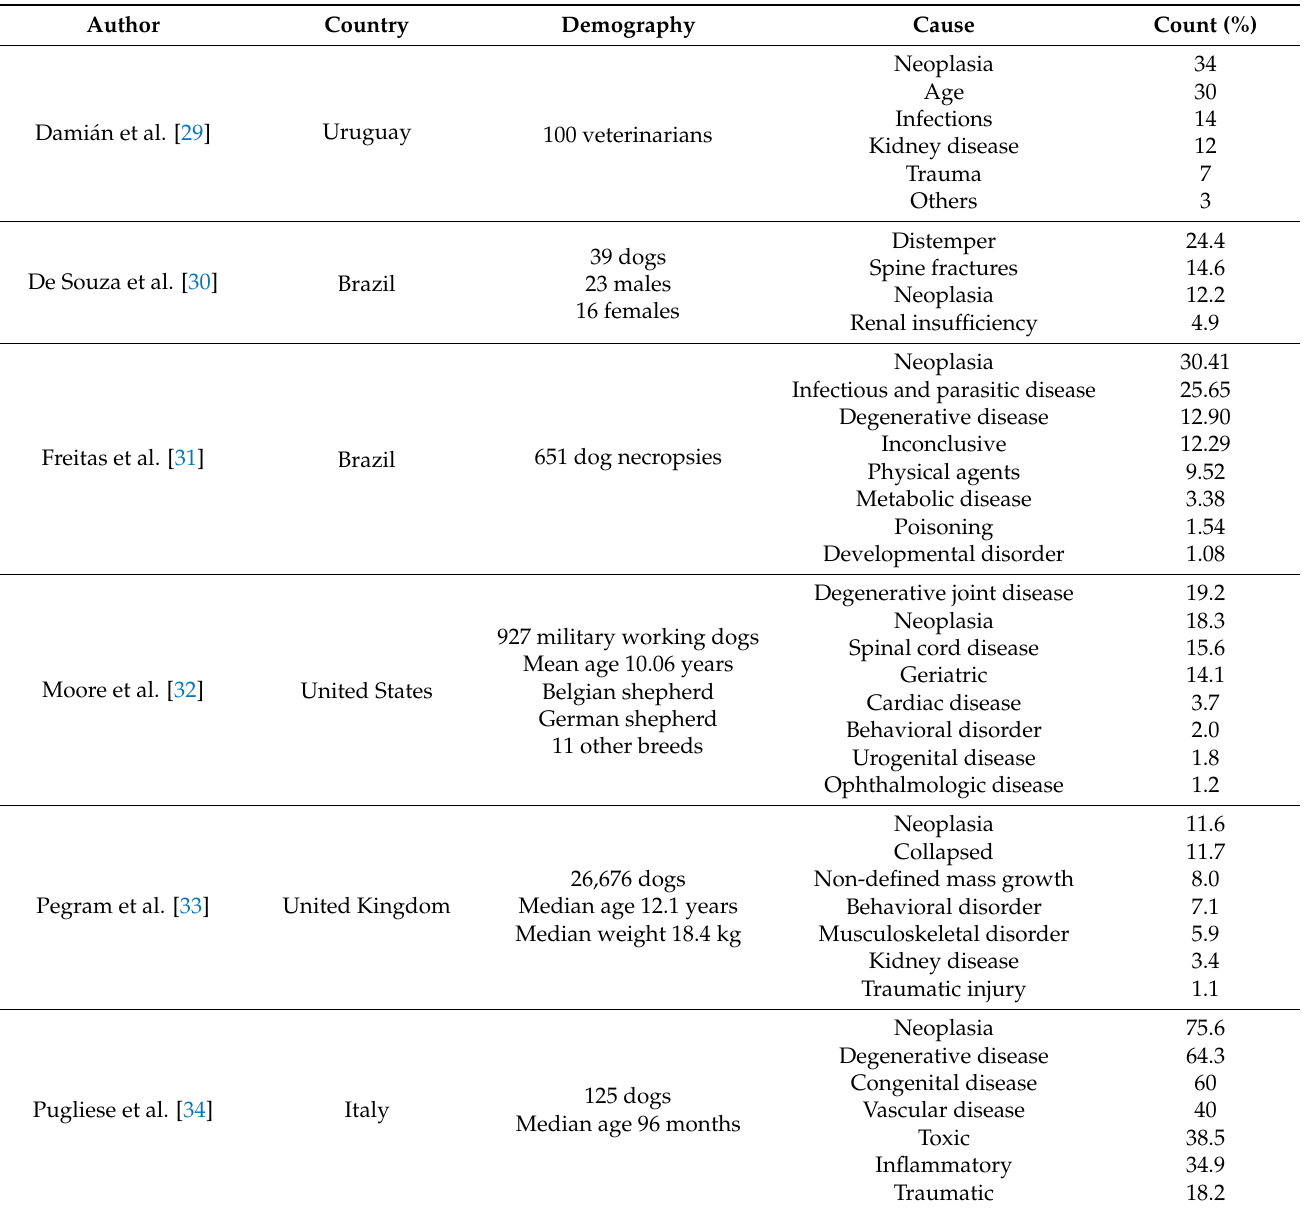
Table 1. Main causes of euthanasia according to different